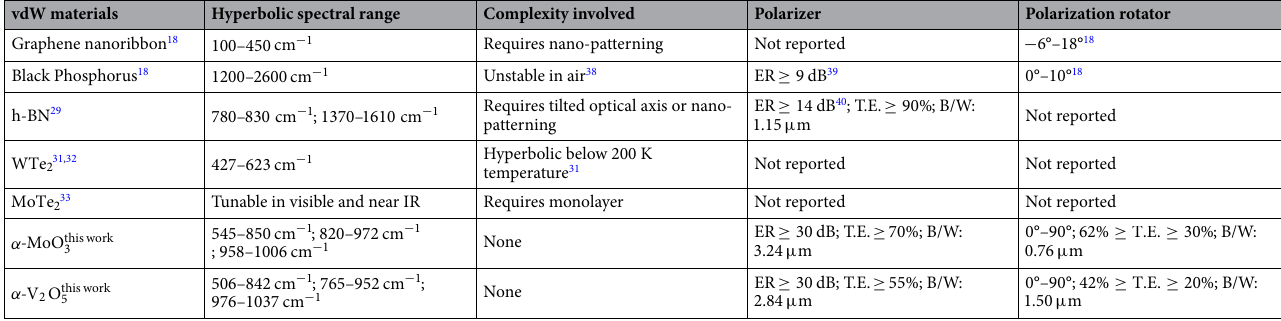
Table 1. Overview of various 2D vdW crystals and their applications in the infrared photonic devices, namely polarizer and polarization rotator. ER extinction ratio, T.E. transmission efficiency, B/W